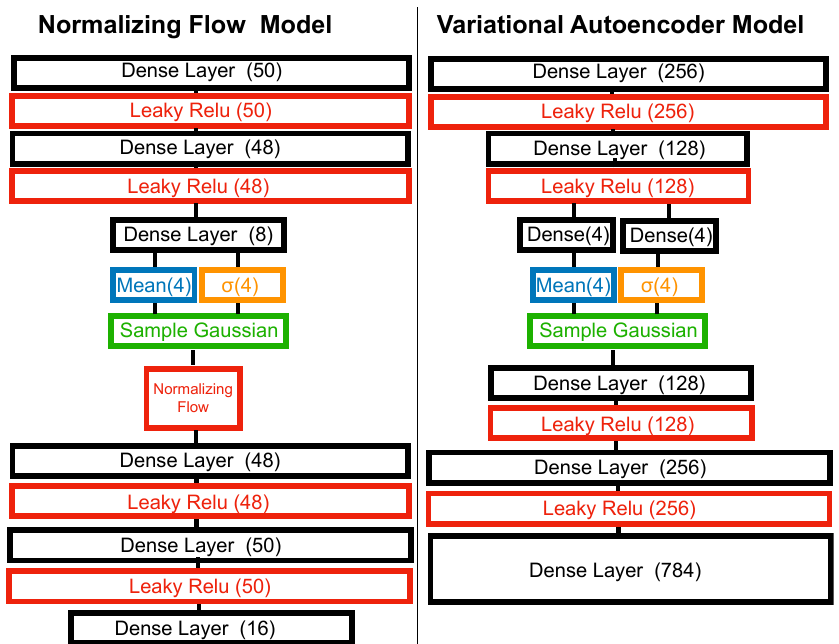
Figure 5 . (Left) Illustration of the Normalizing Flow variational autoencoder network used for dijet identification. (Right) Illustration of the variational autoencoder used for the MNIST study. The number in parentheses indicates the number of output nodes of each